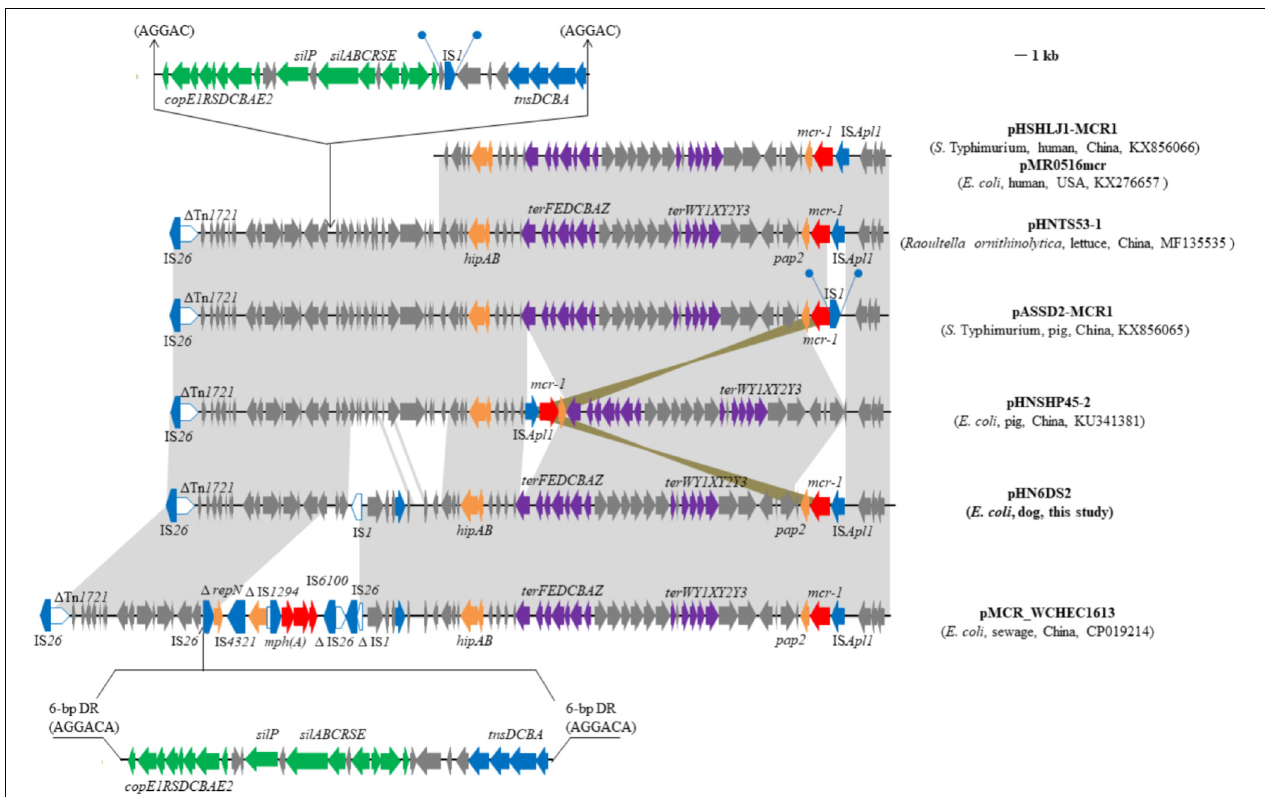
FIGURE 2 | Genetic organization of the partial sequence containing mcr-1 of plasmid pHN6DS2, and structural comparison with other mcr-1 -carrying plasmids. Arrows indicate the positions of the genes and the direction. Regions with > 99% homology are shaded in gray or azure. (cid:49) indicates a truncated gene or mobile element. Direct repeats are indicated by arrows and blue circles. Tall bars represent the 38 bp inverted repeat (IR) of transposons. The backbone is indicated by dotted